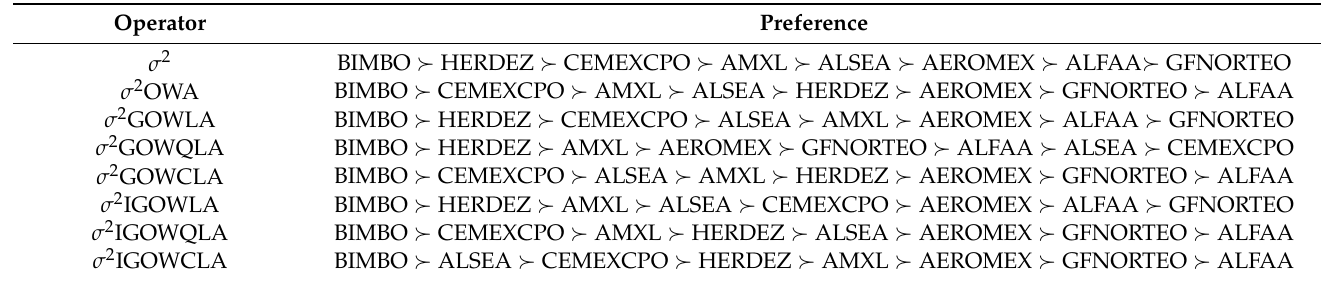
Table 7. Ranking based on lowest dispersion.